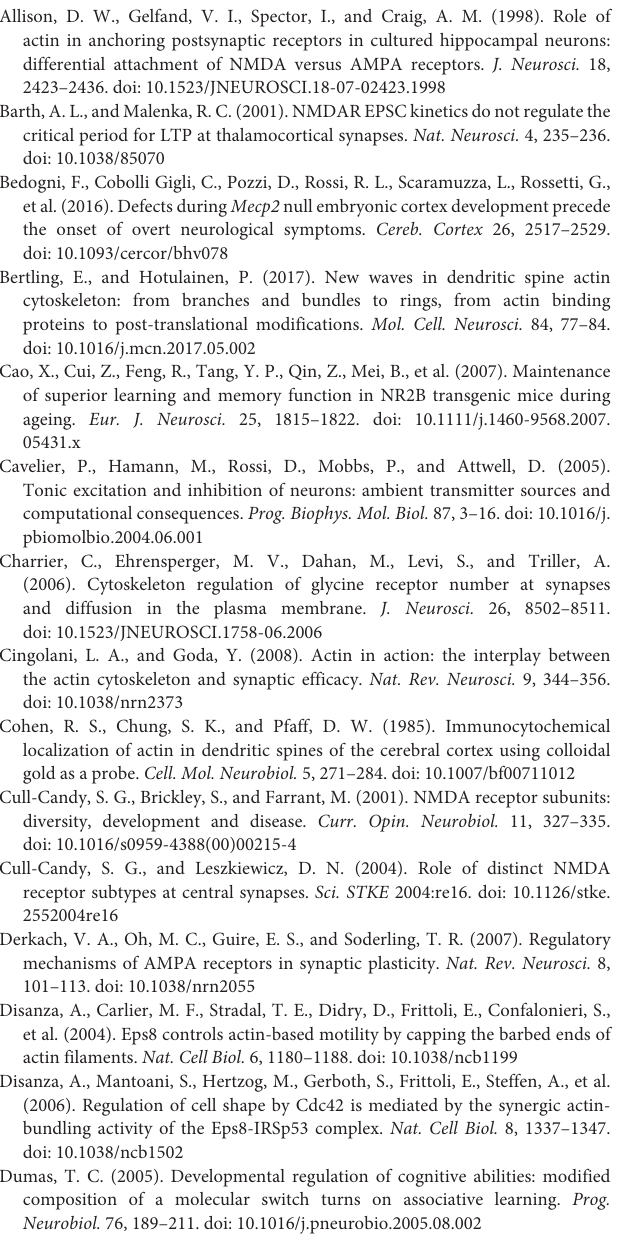
35.45 ± 5 n = 10 cells; Mann Whitney test ∗ P = 0.022; KO ctrl: 22.96 ± 1.9 n = 12 cells, KO TTX: 30.4 ± 2.8 14 cells; Unpaired t -test, ∗ P = 0.044). (C) Example of AMPA-mediated EPSCs recorded at +40 mV and at − 60 mV in WT (top) and EPS8 KO neurons (bottom). (D) Summary bar graphs of rectification index analysis (RI: amplitude response at 40 mV/amplitude response at − 60 mV) showing no difference in RI value between the two genotypes. All data shown represent the mean ± SEM (Mann Whitney test P = 0.5501). FIGURE S2 | Representative images of primary hippocampal neurons treated or not with LatrunculinB (300 nM from 10 DIV to 14 DIV). At 14 DIV neurons were fixed and stained for the postsynaptic markers PSD-95 (green) and for actin filaments by using the specific compound phalloidin. Scale bar depicts 10 µ